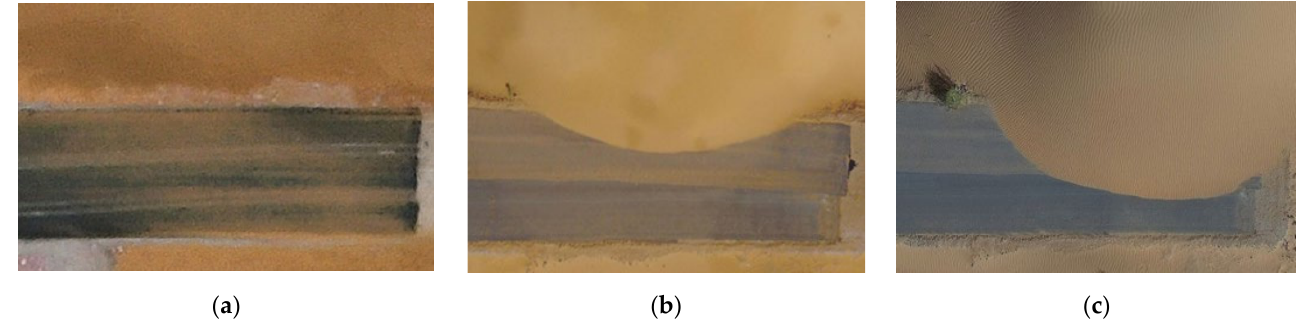
Figure 6. Change of sand-accumulation area on windward side of embankment: ( a ) winter in 2020, ( b ) spring in 2021, and ( c ) summer in 2021. Table 1. Area of the sand sedimentation on highway surface statistical table.